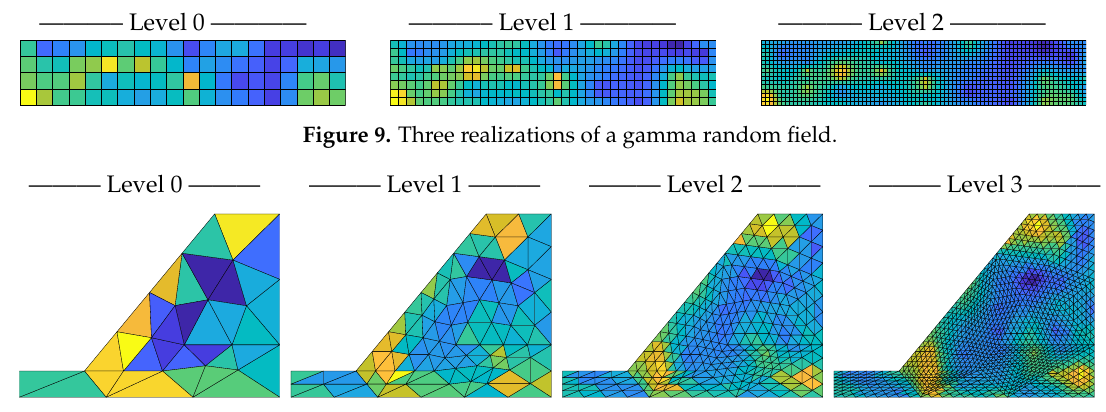
Figure 10. Four realizations of a lognormal random